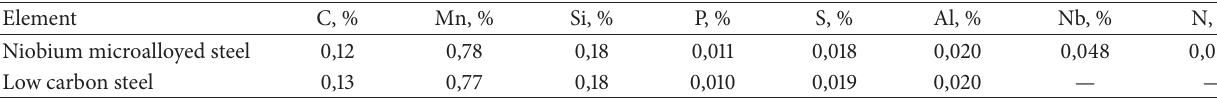
Table 1: Chemical composition of steels [2].